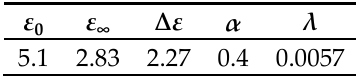
Table 1. Parameters in Equation (10) for a PS/PANI-based ER fluid. (Reprinted from [128], Copyright The Royal Society of Chemistry, 2015).